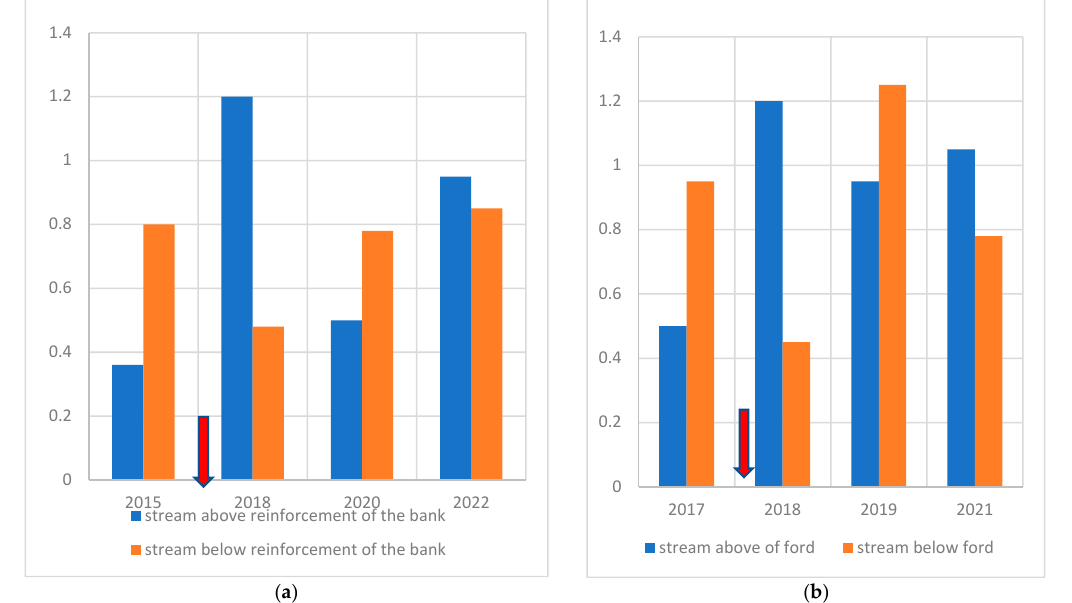
Figure 13. Comparison of larval density C. heros per 1 m 2 of suitable sediment (y-axis) in different years at sites: ( a ) with the effect of repair of reinforcement (site Bun č ovský potok stream); ( b ) with the effect of using of ford across stream (site stream of Salaška); red arrow shows the occurrence of the phenomenon.